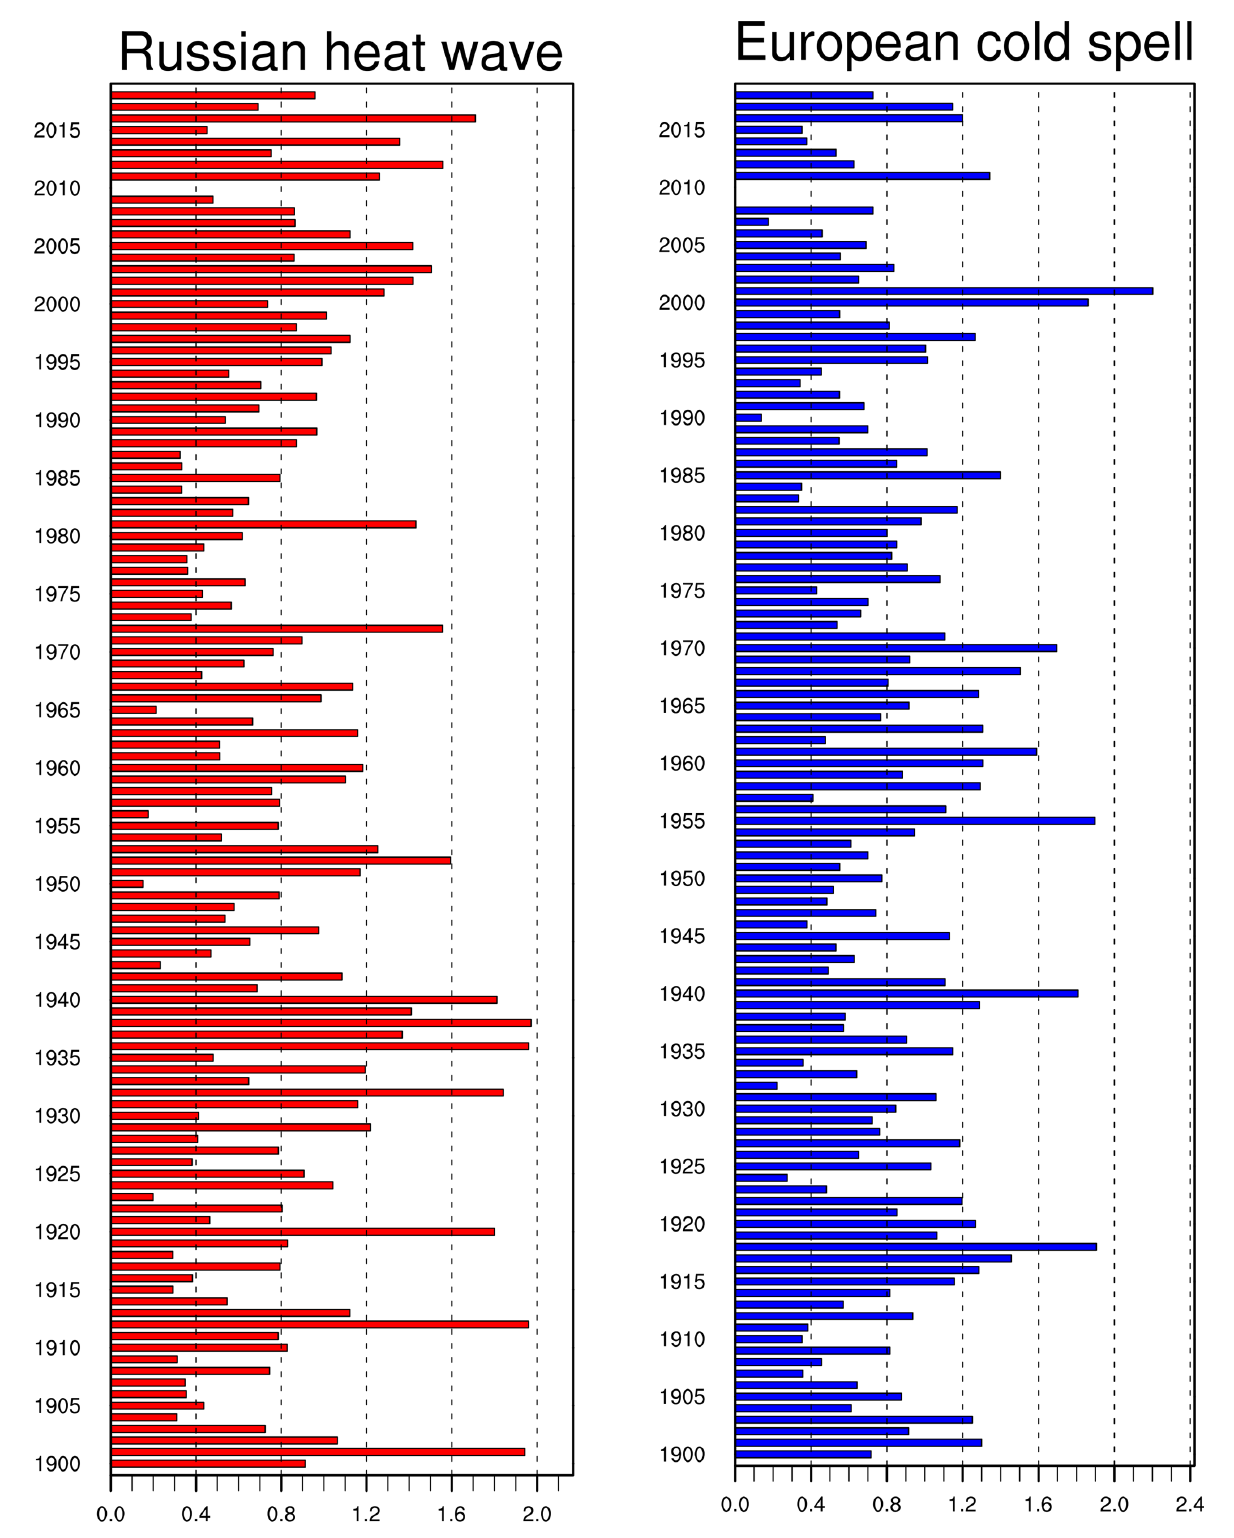
Figure B1. Time distribution of selected SLP analogues ( X axis, unit in percent of the total number of used analogues) versus their year of occurrence ( Y axis) for the two extreme